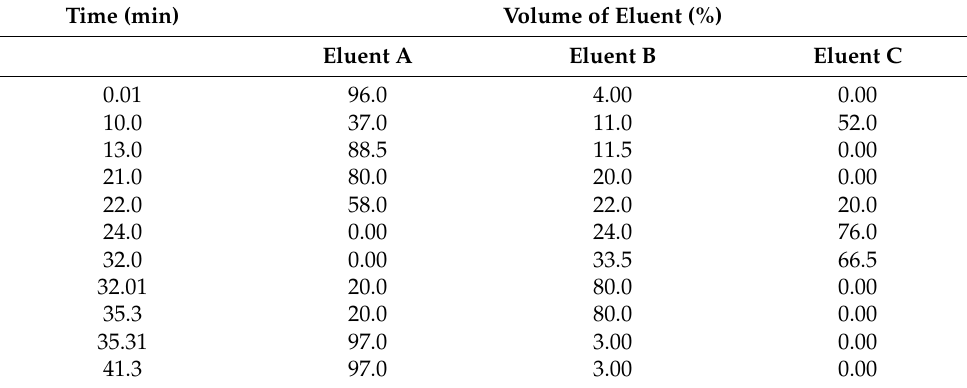
Table 2. Gradient mode parameters of HPLC determination of amino